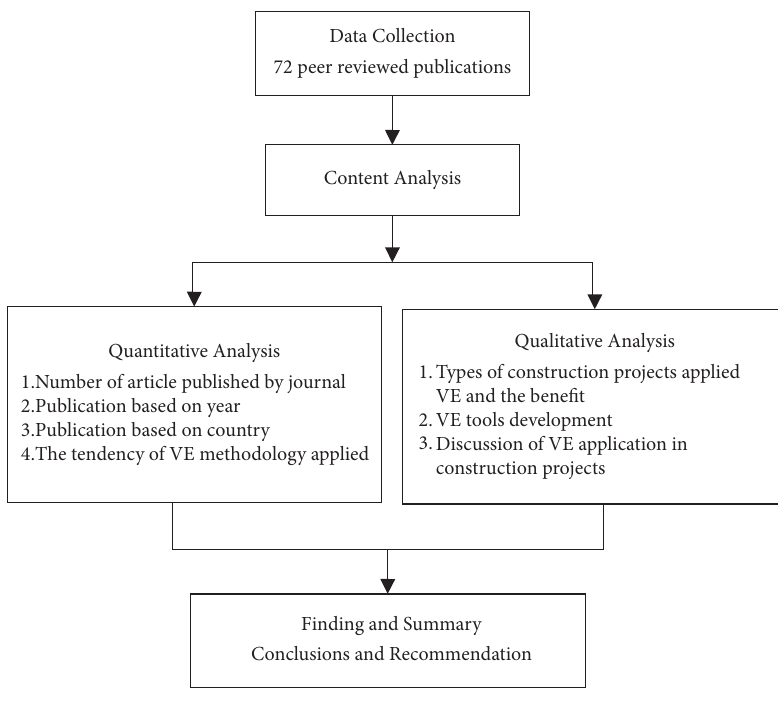
Figure 2: Content analysis